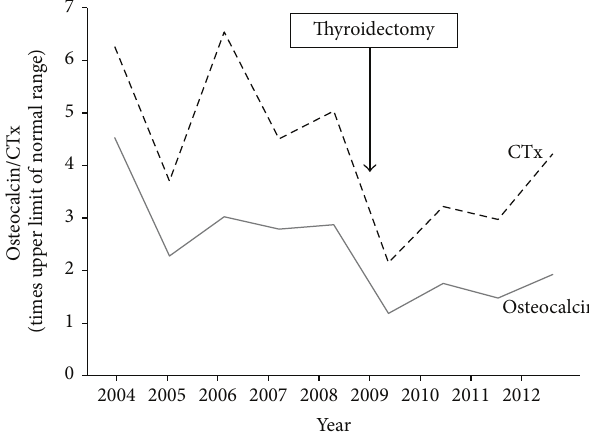
Figure 4: Changes of markers of bone turnover after thyroidectomy. Full line: osteocalcin; dotted line: serum collagen type 1 cross-linked C-telopeptide